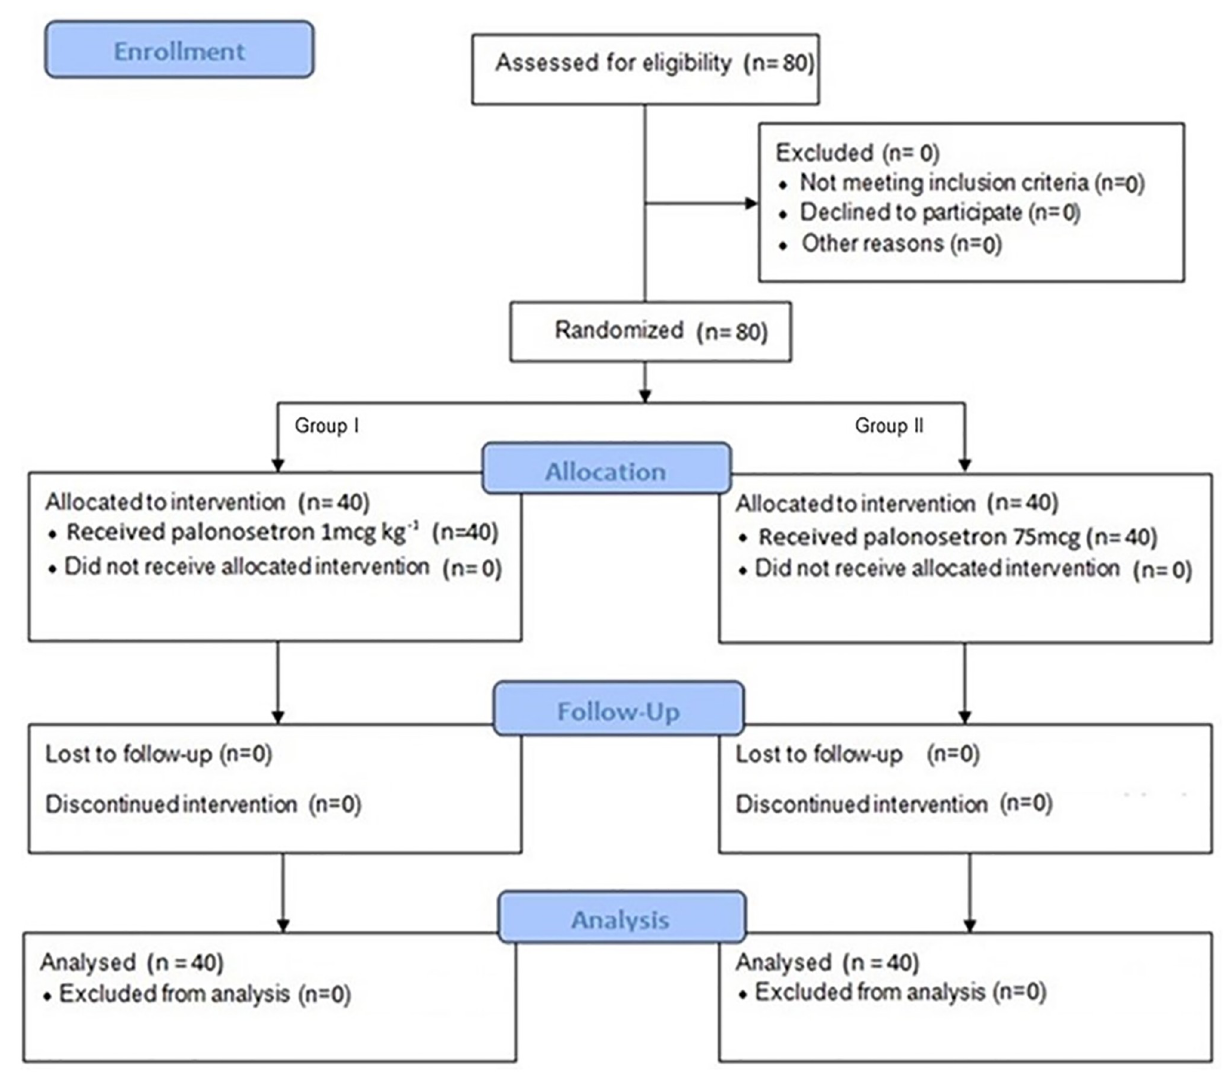
Fig 1. Flow chart of the study—CONSORT.